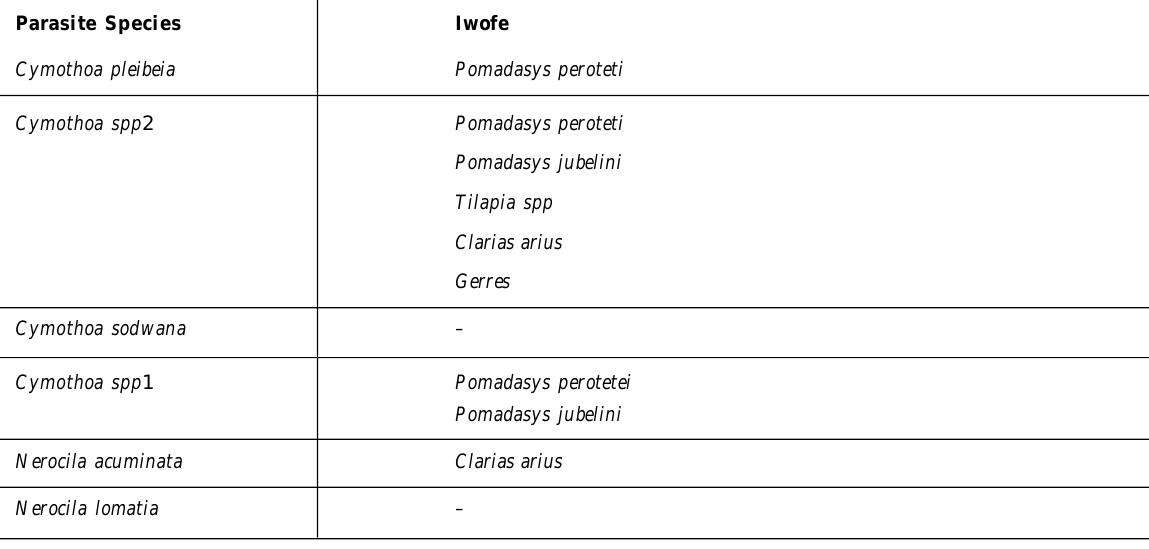
Table 3: Parasitological index of the Cymothoid parasites isolated for the period of study Host Species/